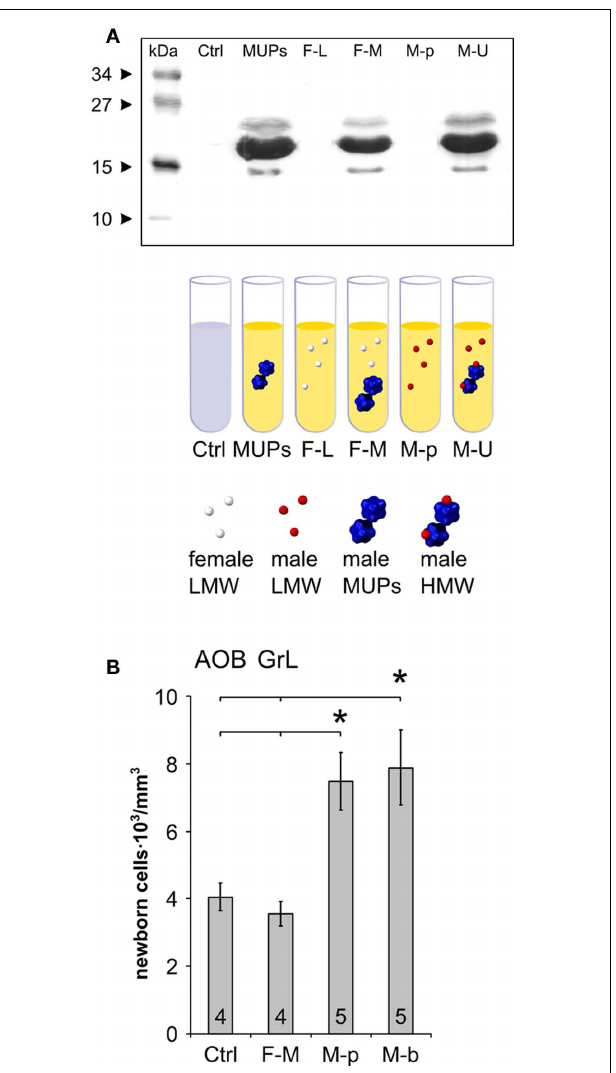
FIGURE 3 | Male urine LMW pheromones increaseAOB granule cell survival. (A) Strategy for isolating different urine fractions. Protein gel electrophoresis showing the protein content in each fraction (MUPs: male HMW urine fraction containing MUPs treated with menadion, F-L: female LMW fraction used as diluting solution for male MUPs, F-M: female urine LMW fraction loaded with male MUPs, M-p: male urine treated with proteases, M-U: male urine). Proteins ( > 10kD) are present only in those fractions of male urine that contain MUPs. HMW proteins are absent in female LMW urine fraction or male urine after protease treatment. (B) Densities of 28days old BrdU-positive cells in the AOB–GrL after exposure to different fractions of male urine or male soiled bedding (M-b) during the 2nd week after injection. Means ± SEM, number in each bar indicates the amount of animals used, *P < 0.05, * *P <